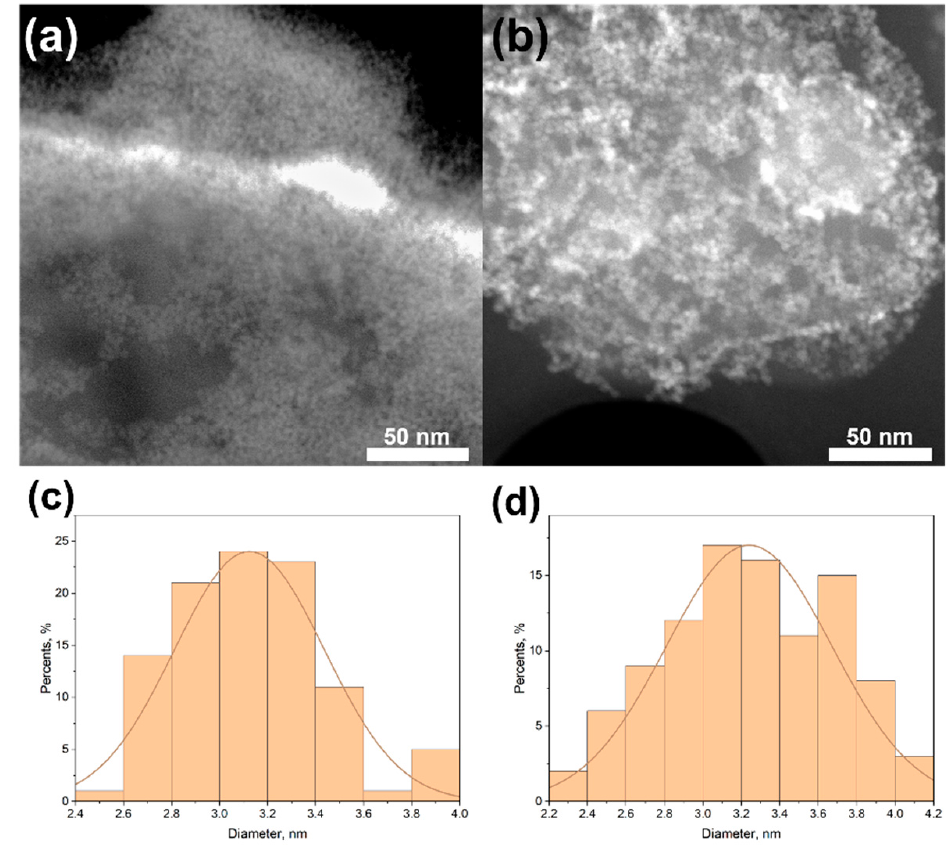
Figure 2. Characteristic STEM micrographs and ZnO NPs size distributions of ZnO/ h -BN µ m ( a , c ) and ZnO/ h -BNnm ( b , d ) heterostructures.